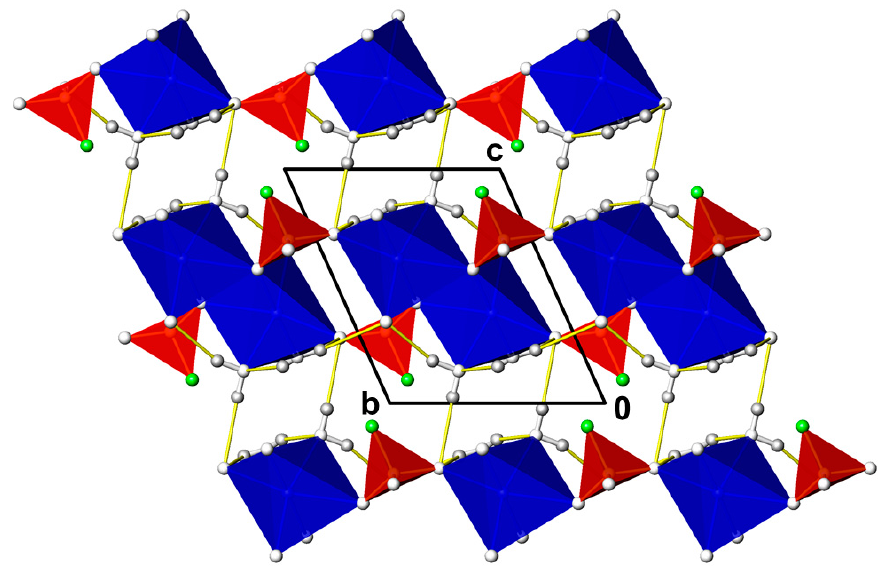
Figure 1. The crystal structure of CdPO 3 F(H 2 O) 2 in a projection along [100]. PO 3 F tetrahedra are given in red (O atoms as colourless, F atoms as green spheres), [CdO 6 ] octahedra are given in blue, and H atoms are given as grey spheres. O–H···O hydrogen bonding is indicated by yellow lines.